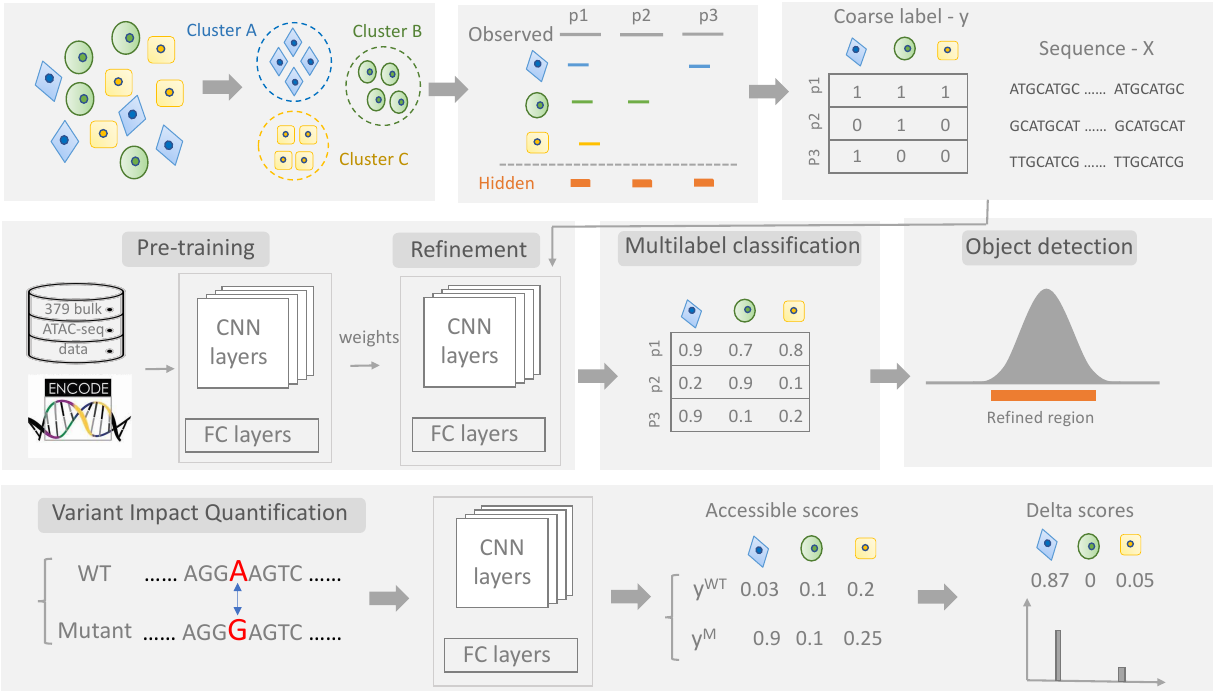
Figure 1. The overall design of the scEpiLock Method. The standard processing of scATAC-seq outputs coarse peaks and labels for each cell. scEpiLock takes the processed scATAC-seq cell x peak label matrix (y) and peak sequence (X) as inputs. First, the multi-label classifier module learns the biological pattern through CNN and makes multi-label predictions. Second, the object detection module refines the peak boundaries and localizes the potential cis -regulatory elements within the given peaks. Third, the variant impact quantification module computes the delta scores of candidate mutations and identifies their accessibility in a cell-type-specific